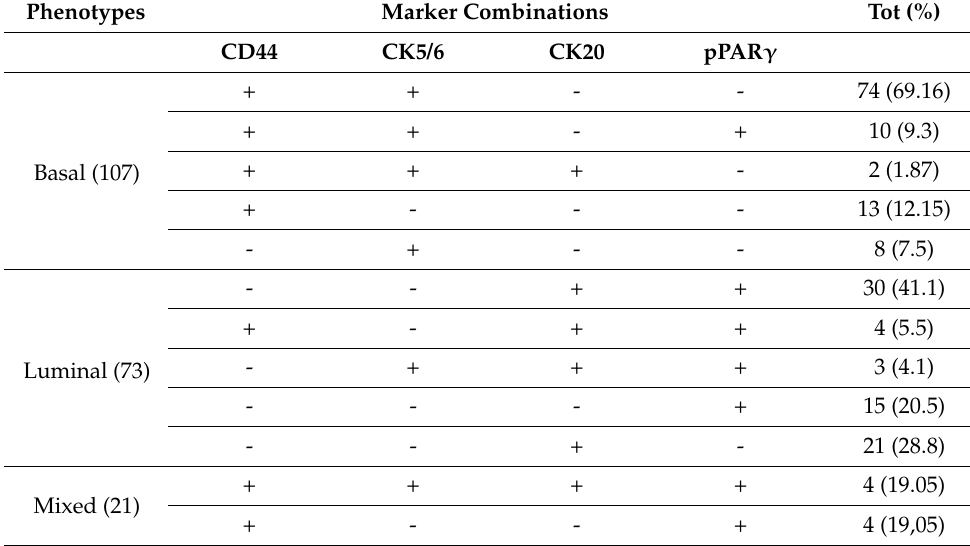
Table 3. Stratification of patients in the four phenotypes using the different marker combinations.